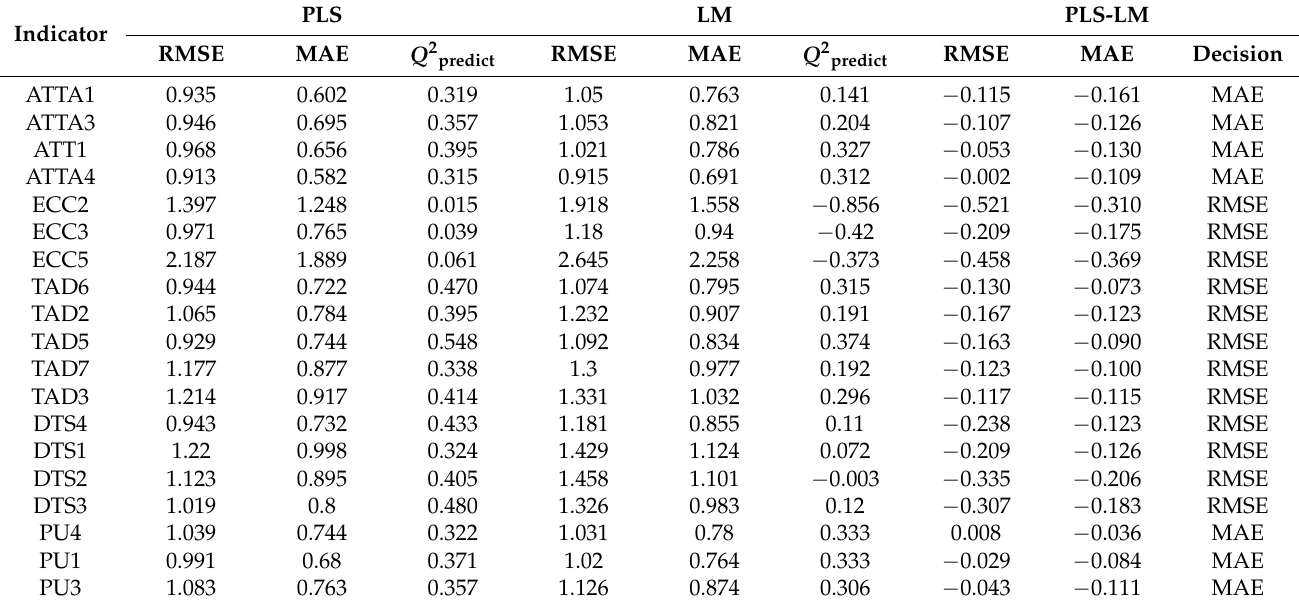
Table 18. The difference in RMSE or MAE errors between PLS and LM (predictive